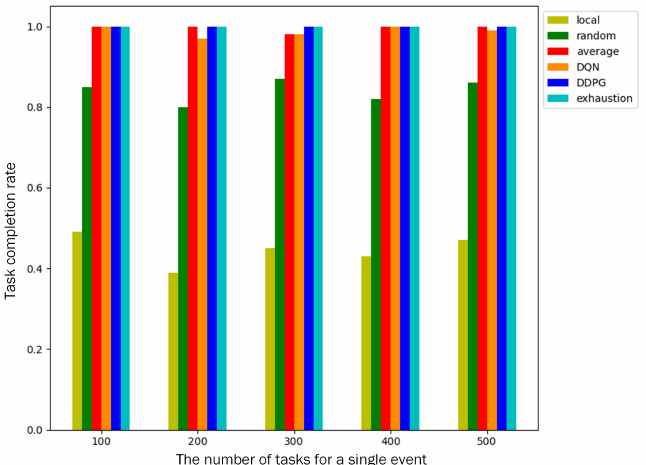
Figure 7. Task completion rates for a different number of tasks in an